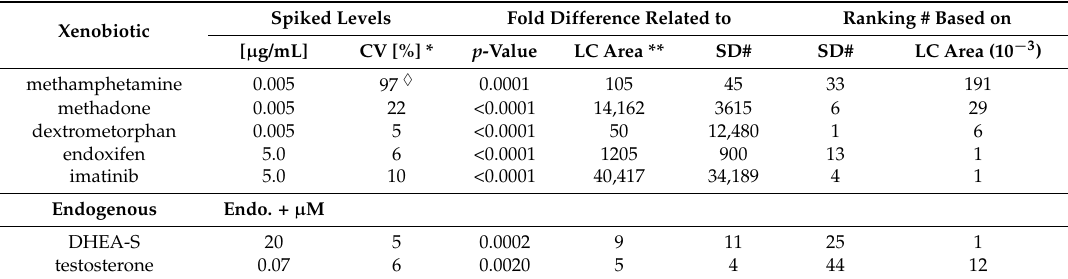
Table 3. Spiked compounds revealed in the metabolome of the test sample in comparison to 95 healthy metabolome samples using the UDS procedure. Fold difference between the test and control samples are given as ratio of mean LC-HRMS peak area or SD# (the number of SD [or σ ] between LC-HRMS peak area). These two values are also used to rank the metabolites.